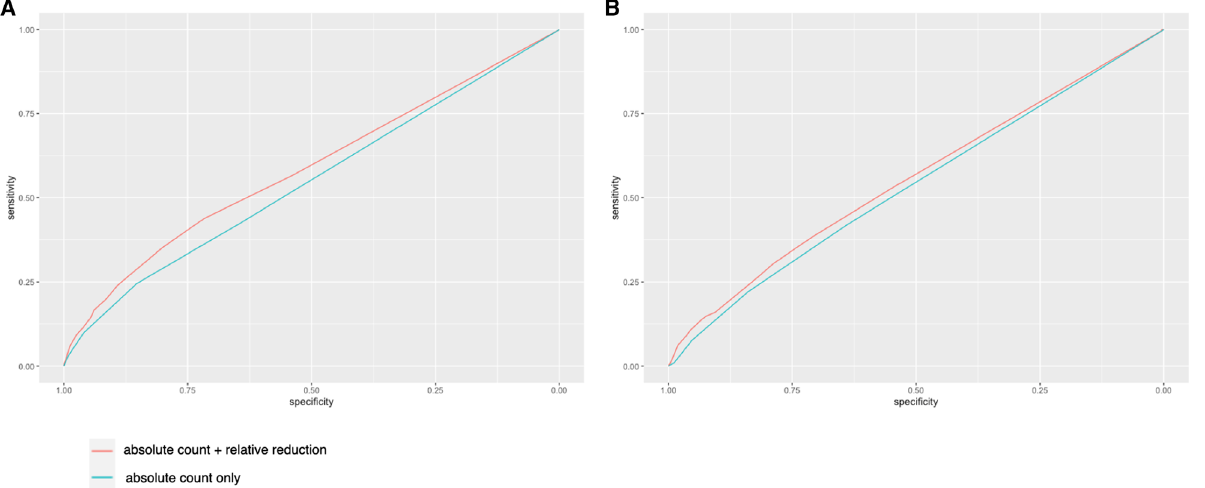
Figure 4. The result of Receiver operating characteristic curve analysis. Predictive validity of platelet counts alone and absolute platelet counts plus relative platelet reductions for in-hospital mortality ( A ) and coagulopathy-related complications ( B